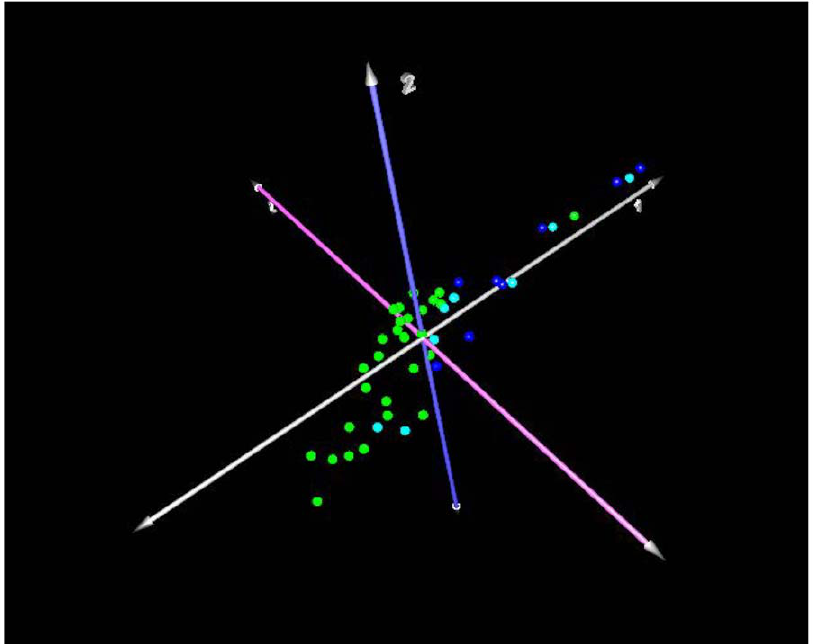
Figure 1. Principal component analysis of mild IPF cases (D L CO $ 65% predicted) compared to controls. Dark blue spheres: definite IPF; Cyan/light blue spheres: probable IPF; Green spheres: healthy controls . Axis labels: white-first principal component; blue-second principal component; lavender- third principal component. The majority of cases, both probable and definite, cluster along the first principal component. Two cases of probable IPF distribute with controls, and one control distributes with cases along the first principal